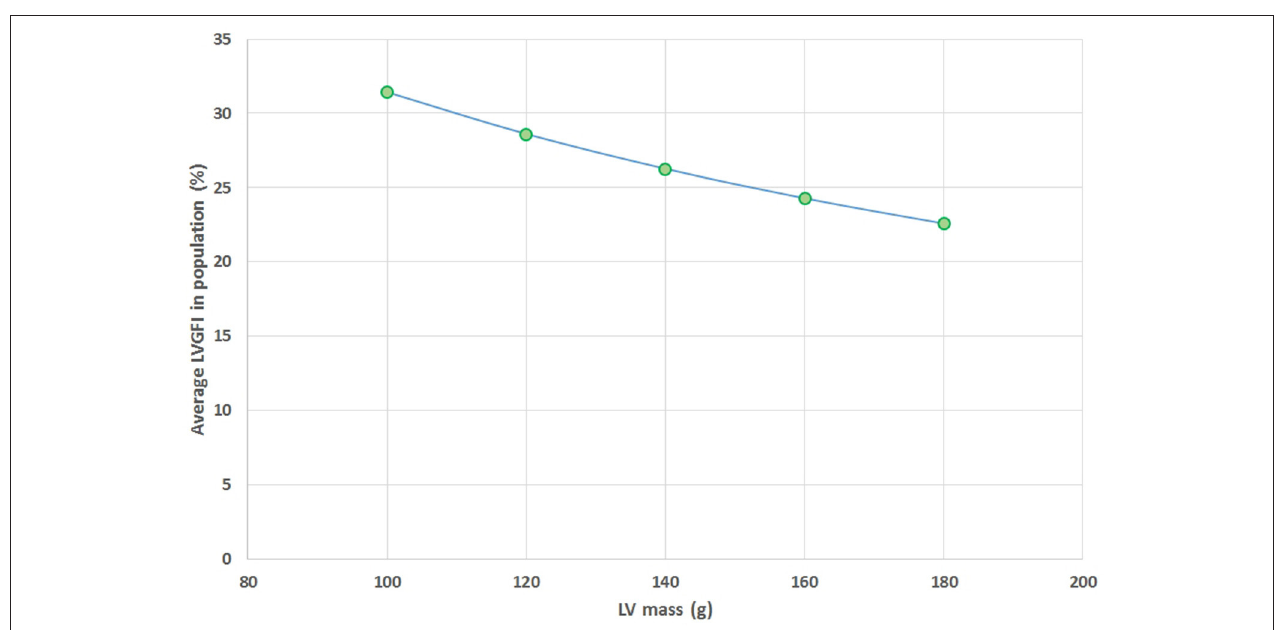
FIGURE 7 | Simulation of LVGFI vs. LV mass (expressed as mL after inclusion of myocardial density), using average values for SV and (EDV patients ( Table 1 ), stratified for sex.